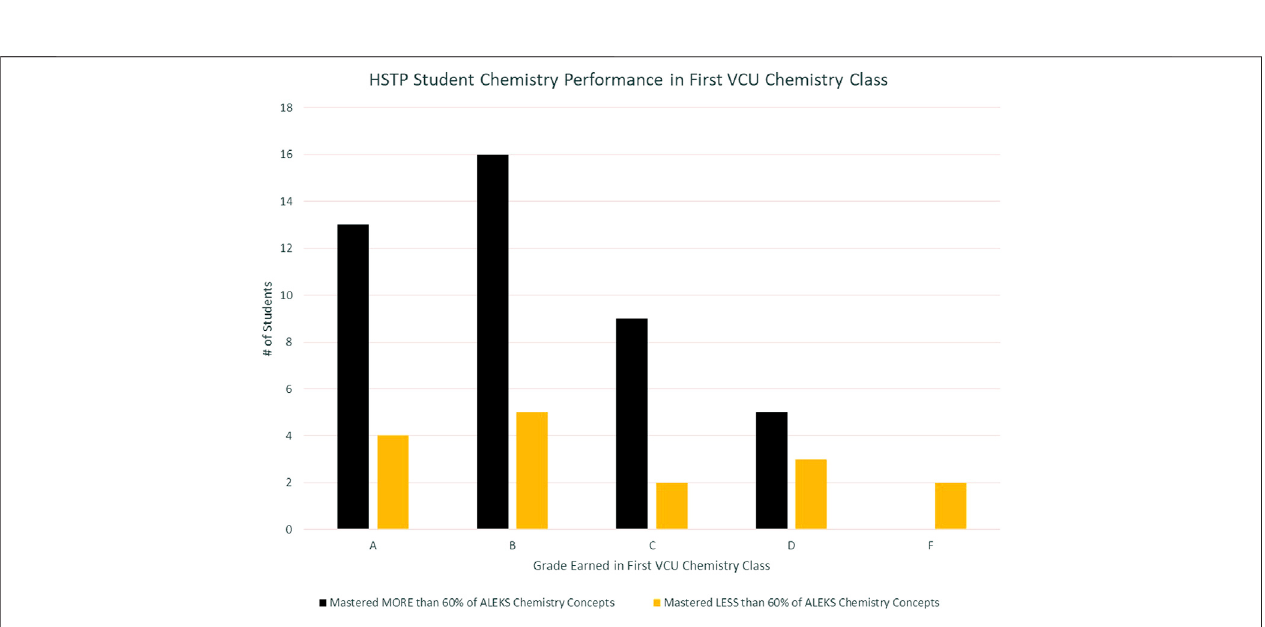
FIGURE 4 | HSTP student performance in fi rst mathematics class taken.